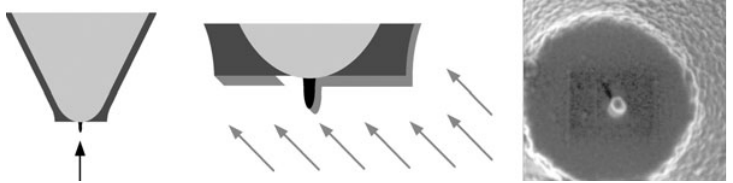
Figure 7 Tip on aperture, fabricated by EBID growth of a nanorod with subsequent metallization. Reprinted with permission from [50] . Copyright 2002, American Institute of